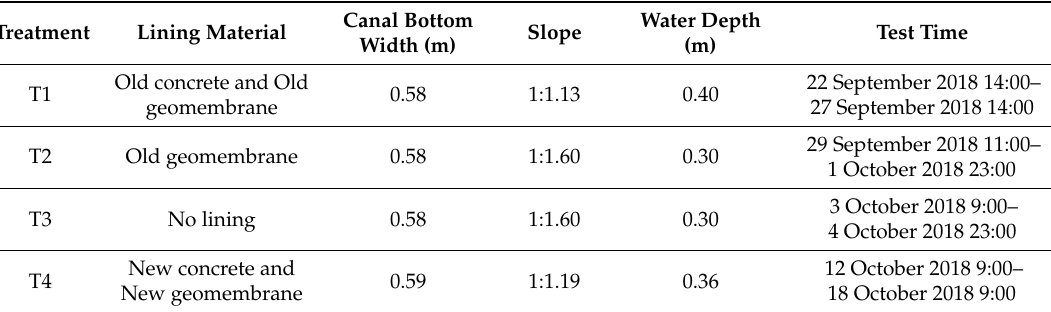
Table 1. Arrangement of four ponding